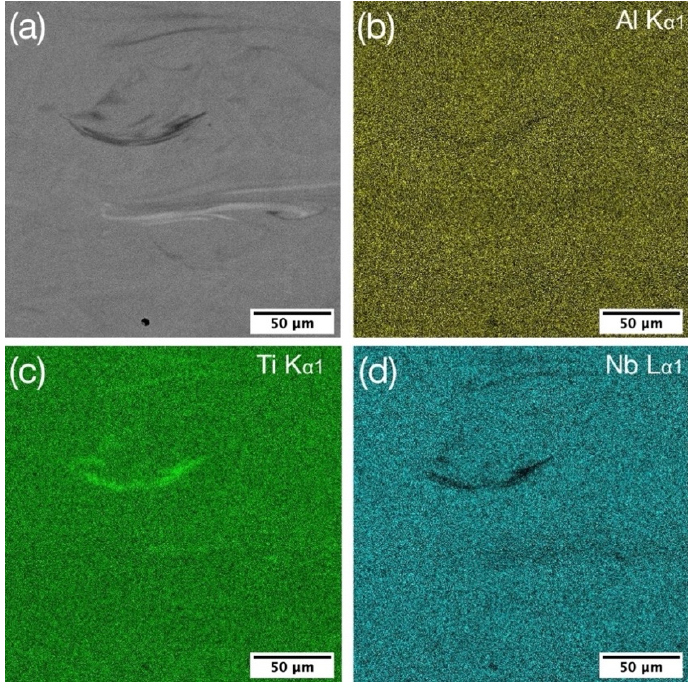
Figure 8. EDS maps of the sample produced from the Ti 2 AlNb-CYB powder at 300 °C substrate preheating temperature: ( a ) BSE-SEM image, distribution of ( b ) Al, ( c ) Ti, and ( d ) Nb.